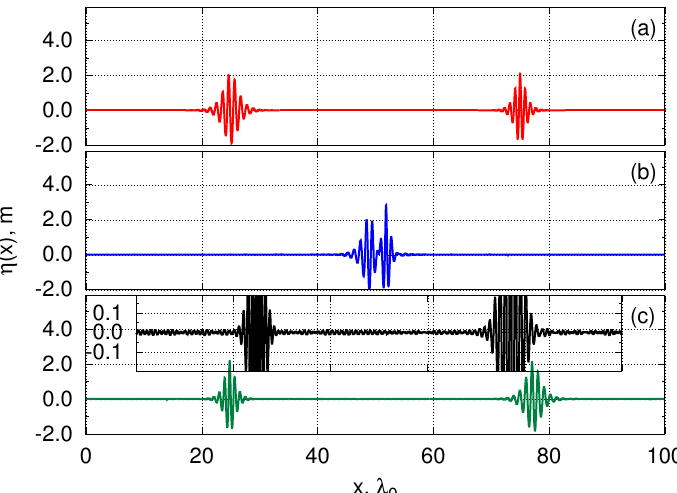
Figure 7. Collision of breathers studied in experiment 3 with the relative velocity ∆ V = 8% and the phase difference ∆ φ ≈ − 2.5. Snapshots show the surface elevation function η ( x ) at the initial moment of simulation (snapshot ( a )); at the moment of maximum amplitude amplification (snapshot ( b )) and at the final moment of simulation (snapshot ( c )). Zoom of the final amplitude profile is shown in the inset of the snapshot ( c